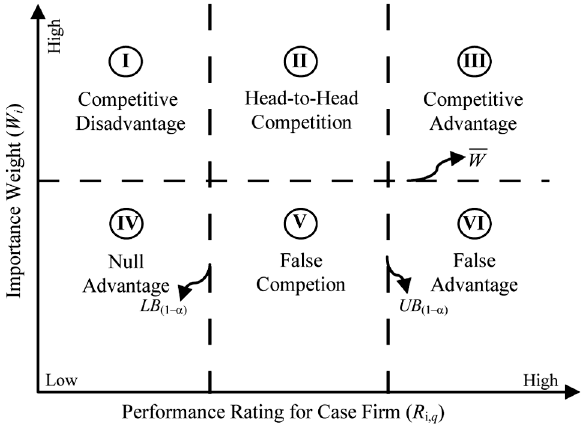
Fig. 1. Confidence interval based importance – performance analysis (CIPA)